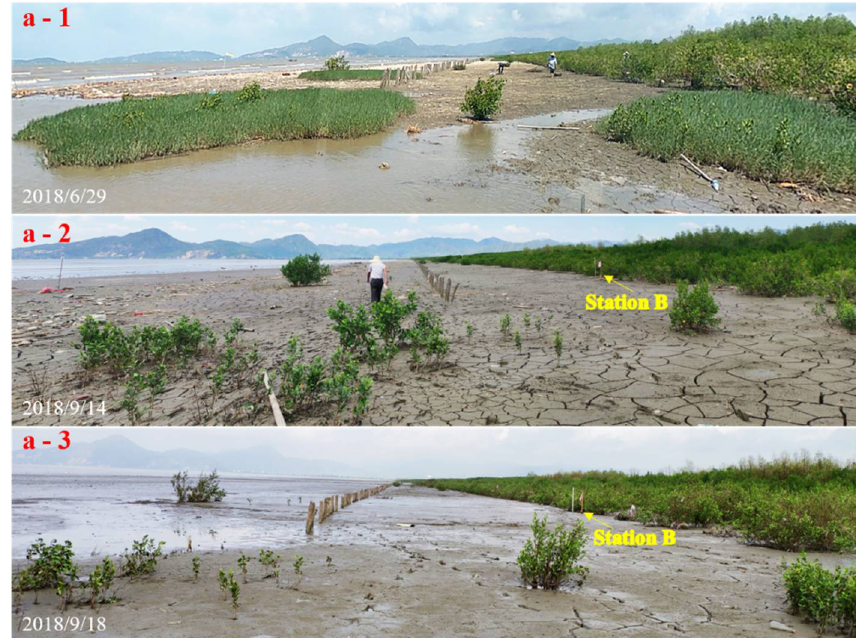
Figure 9. Comparison of tidal flats with both mangrove seedlings and salt grasses in region a (red box a in Figure 8) on 29 June ( a-1 ), 14 September ( a-2 ), and 18 September ( a-3 ), during which obvious sedimentation occurred in this region.